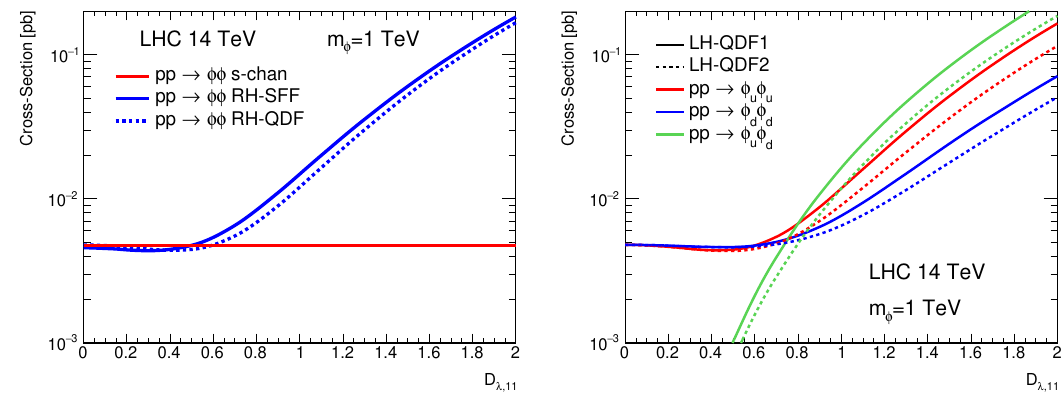
Figure 2 . Cross-section for resonant production of two φ mediators as a function of D λ, 11 at a 14 TeV LHC. The value of m line) benchmarks. Right: cross-section for three configurations: φ LH-QDF1 (solid line) and LH-QDF2 (dashed